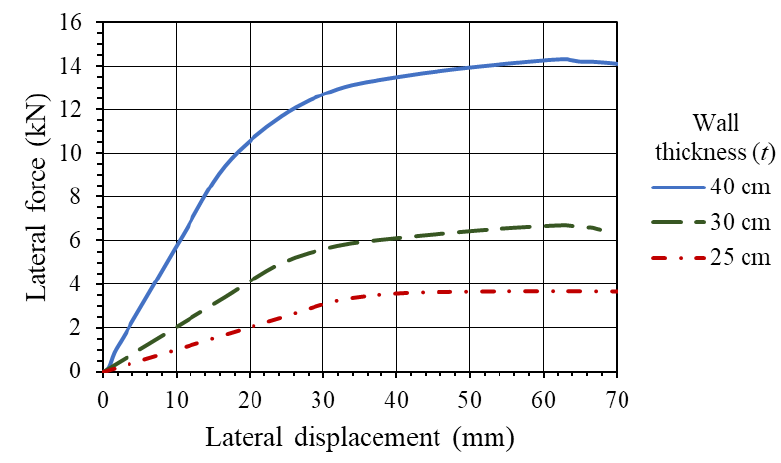
Figure 3. Pushover curves of the dry adobe walls.